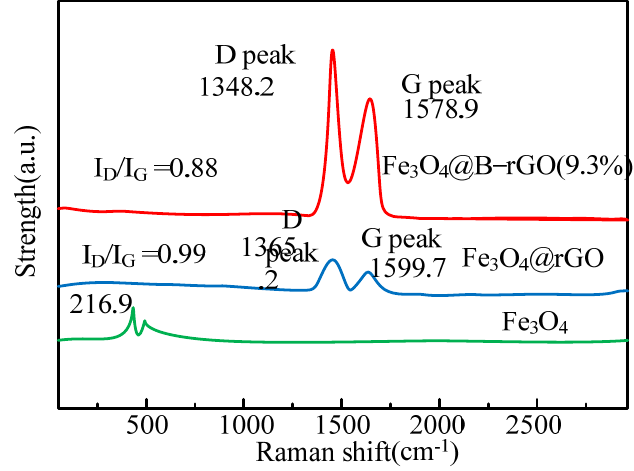
Figure 4. Raman spectra of Fe 3 O 4 @B-rGO (9.3%), Fe 3 O 4 @rGO and Fe 3 O 4 .